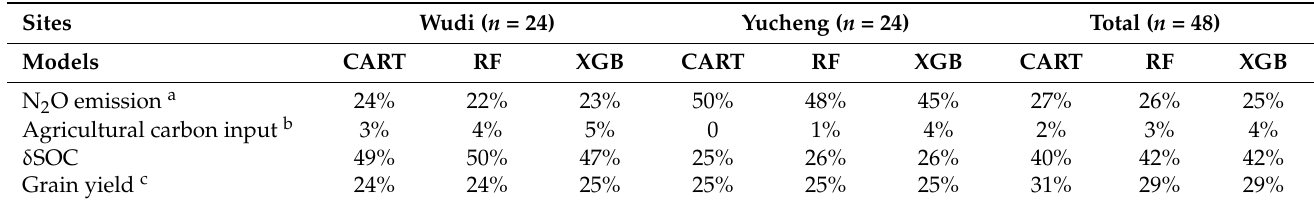
Table 3. Relative importance values of each contributor to the CFy of wheat